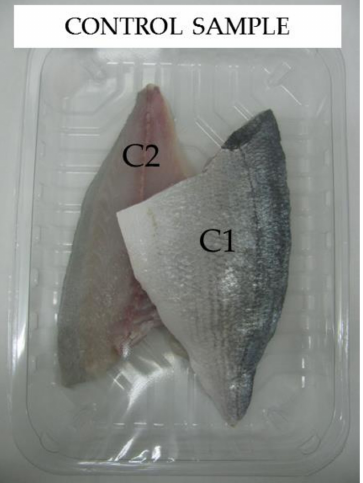
Figure 11. Control sample containing sliced sea